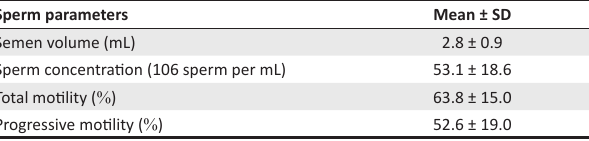
TABLE 1: Baseline analysis of semen samples ( n = 40) obtained from donors. Sperm parameters